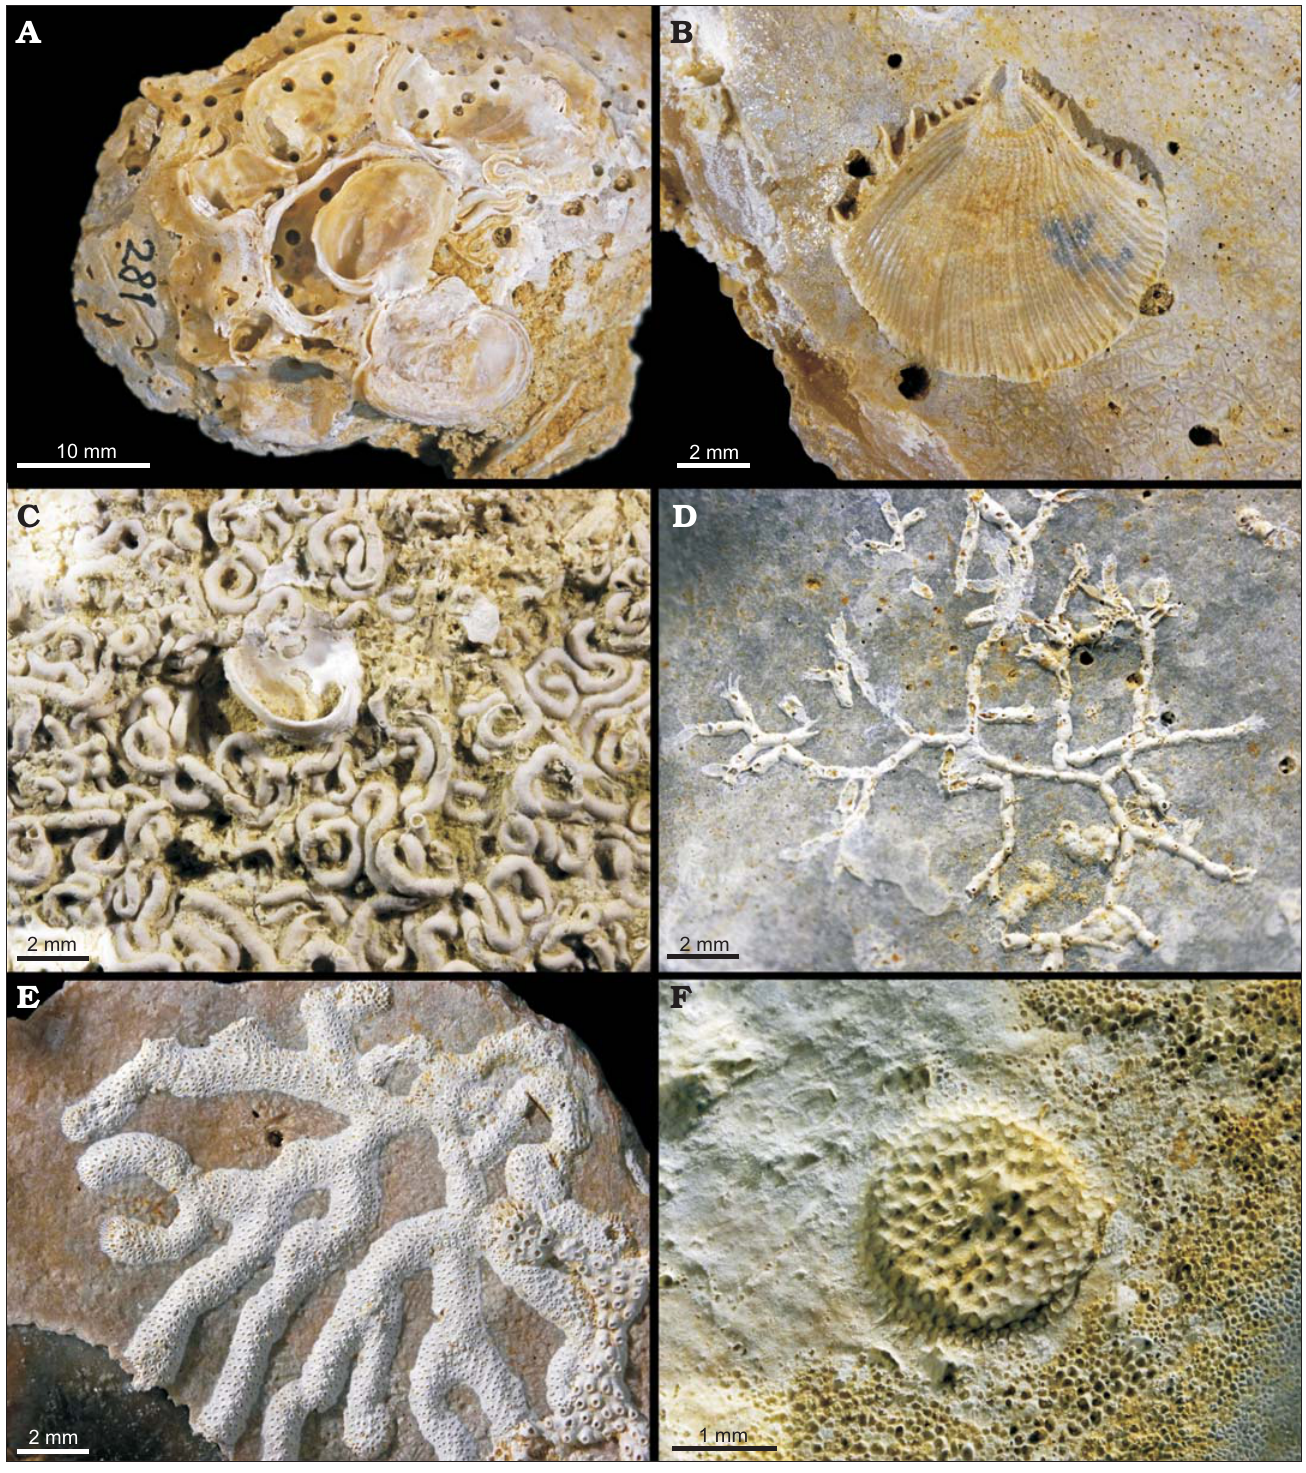
Fig. 1. Epibiosis on oyster Pycnodonte biauriculata (Lamarck, 1819), unless otherwise specified, Marnes à Pycnodonte biauriculata For ma tion,